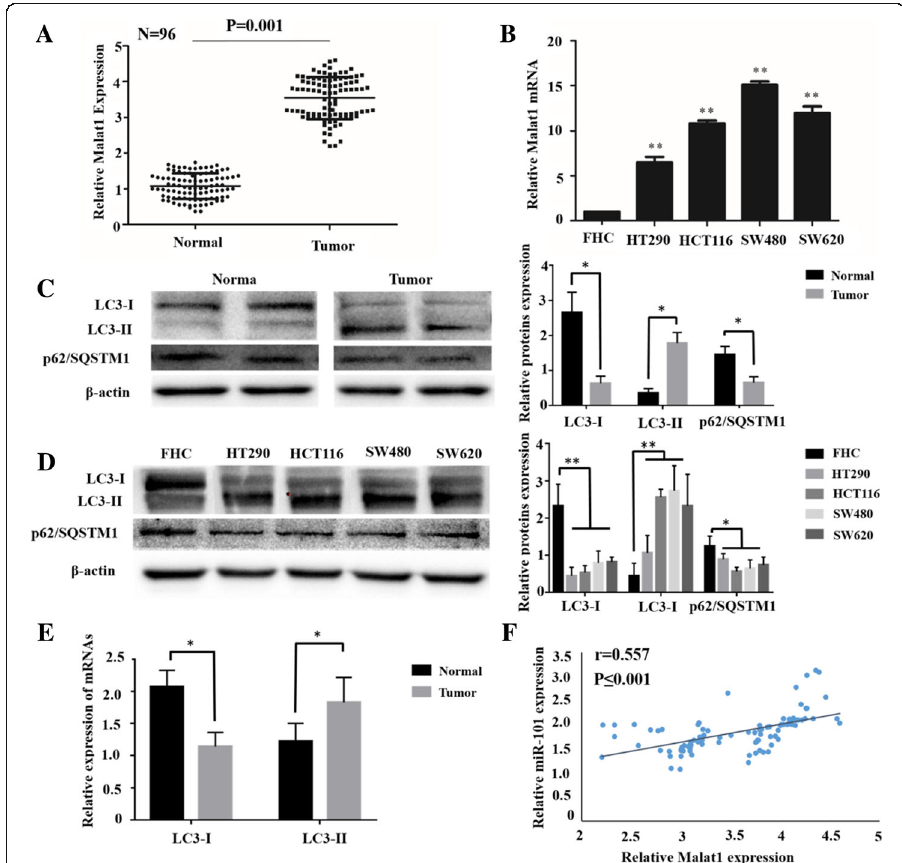
a human normal colorectal mucosa cell line FHC ( b ). HCT116 cell line and SW620 cell line were chosen to perform subsequent experiments. c-d Western blot shows that LC3-II/I and p62/SQSTM1 expression in CRC tissues and adjacent normal tissues ( a ), CRC cell lines and human normal colorectal mucosa cell line ( d ), the columns show the mean for three separate experiments. e qRT-PCR assay shows LC3-II/I expression in CRC tissues and adjacent normal tissues. f A significant positive correlation between Malat1 and LC3-II mRNA levels in CRC tissues. Bars, sd. * p < 0.05, ** p <